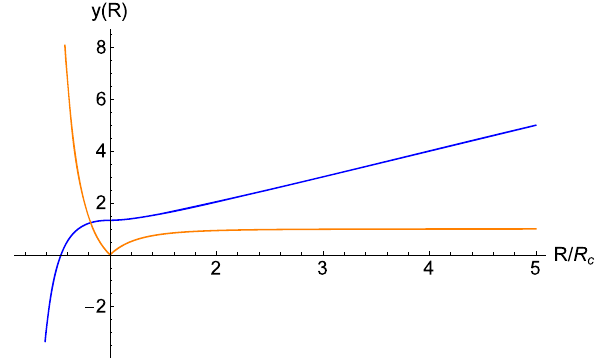
Fig. 1 Thechangeofcoordinates(43)for y ( R ) (blue)anditsderivative y (cid:13) ( R ) (orange). Note that both functions are everywhere continuous